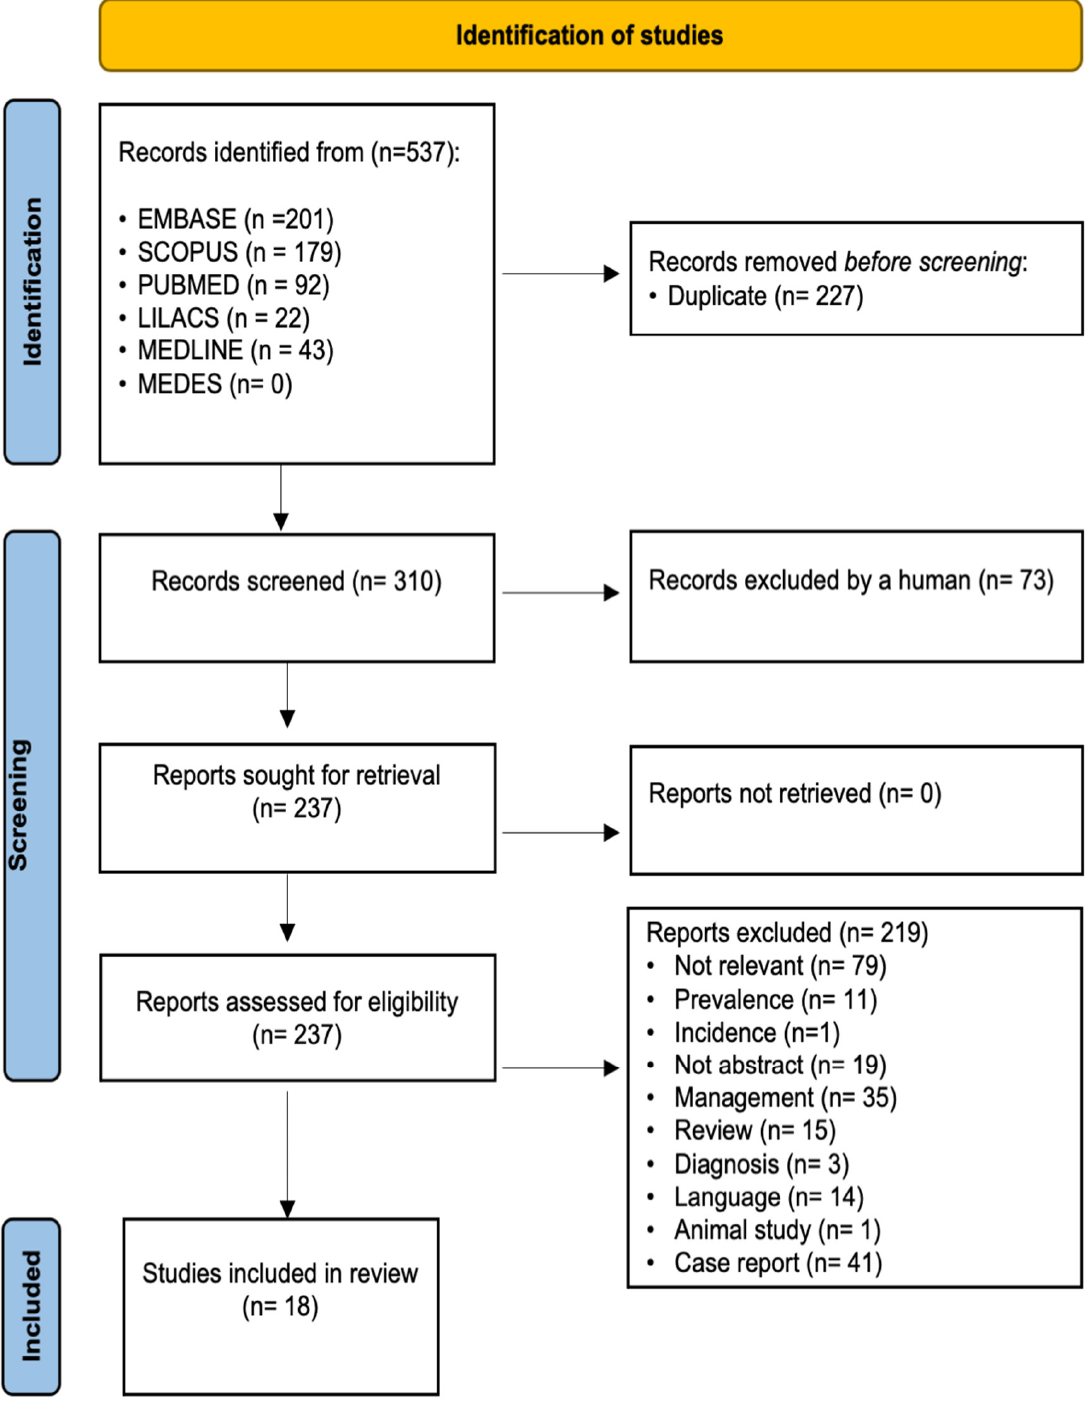
Figure 1. PRISMA Figure 1. PRISMA Diagram.